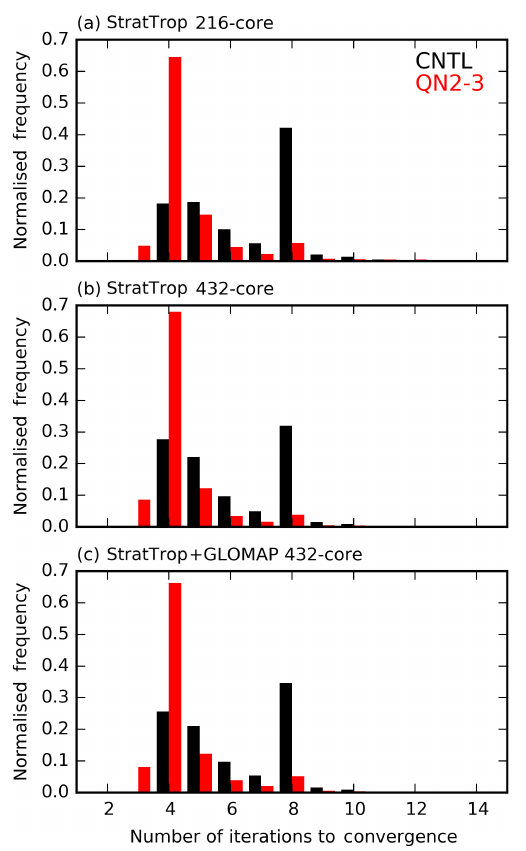
Figure 6. Histograms of the number of NR iterations to conver- gence for the 216-core StratTrop (a) , 432-core StratTrop (b) , and 432-core StratTrop + GLOMAP (c) 1-year long